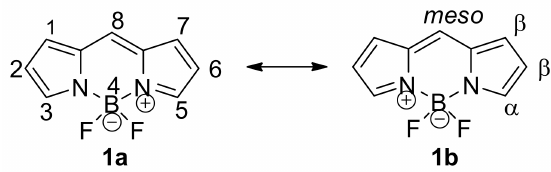
Figure 1. The core structure of 4,4-difluoro-4-bora-3a,4a-diaza- s -indacenes (BODIPY)